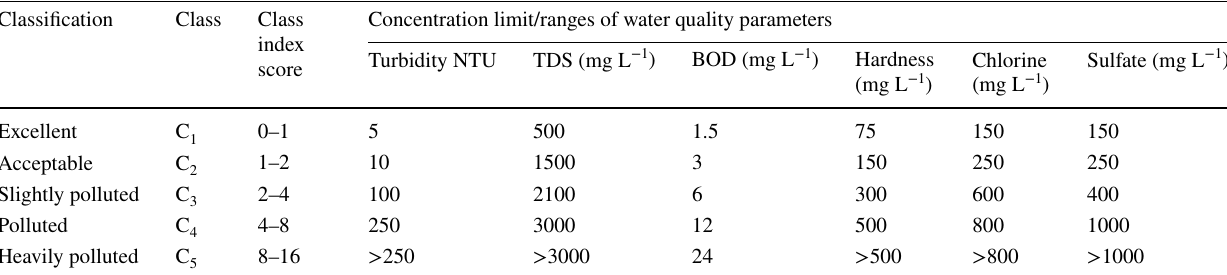
Table 3 Water quality classification in the overall index of pollution (Sargoankar and Deshpande 2003)